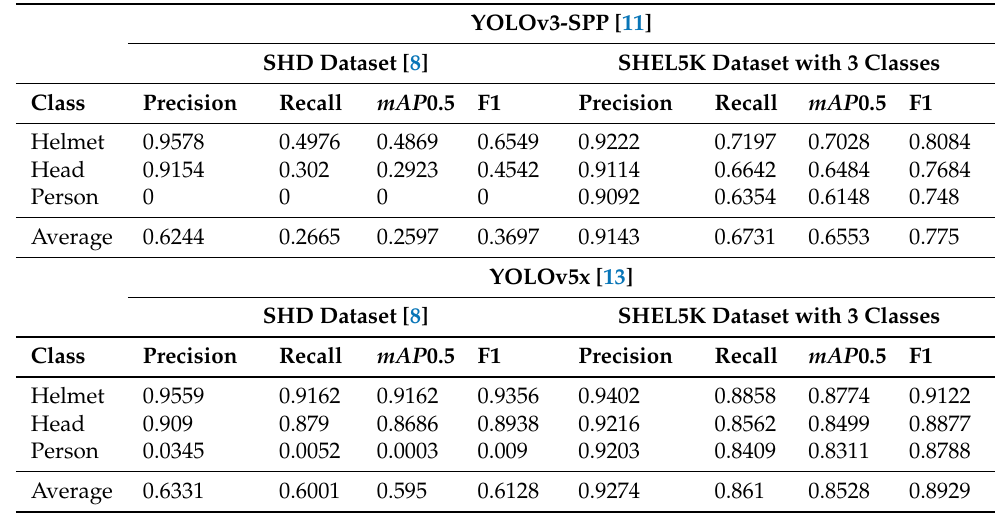
Table 2. Comparison between two dataset results for 3 classes on the YOLOv3-SPP [11] and YOLOv5x [13]